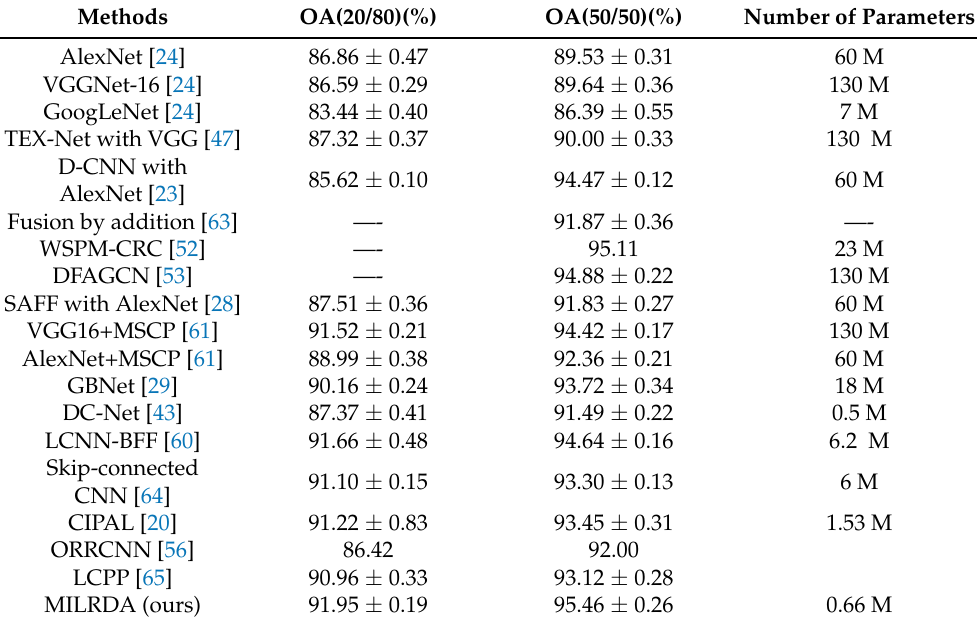
Table 4. Performance comparison on the AID dataset (—-: not